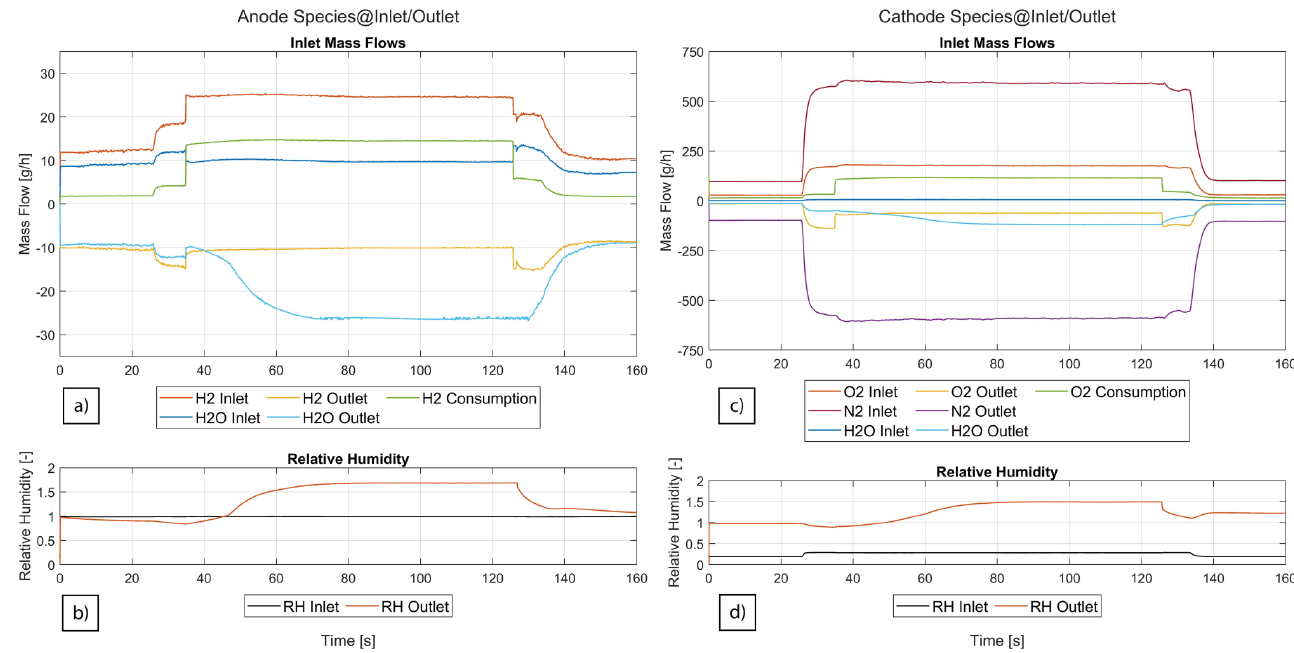
Figure 6. Species mass flows of anode ( a ) and cathode ( c ) are shown for load step L3. Negative values represent outlet mass flows. Relative humidities can be seen in panels ( b , d ). Values higher than 1 indicate that liquid water is present.